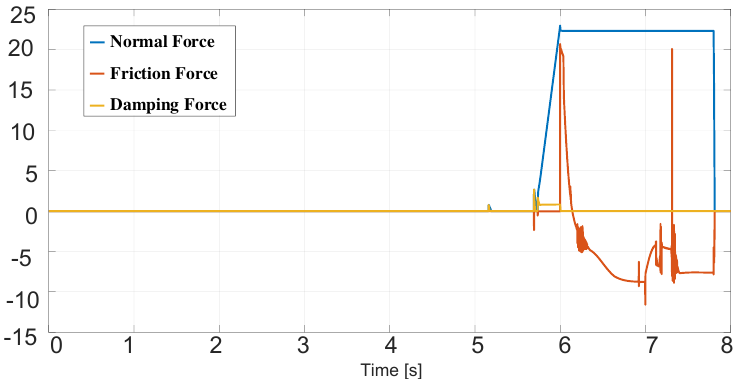
Figure 13. Contact forces between the first finger and the second dumbbell.